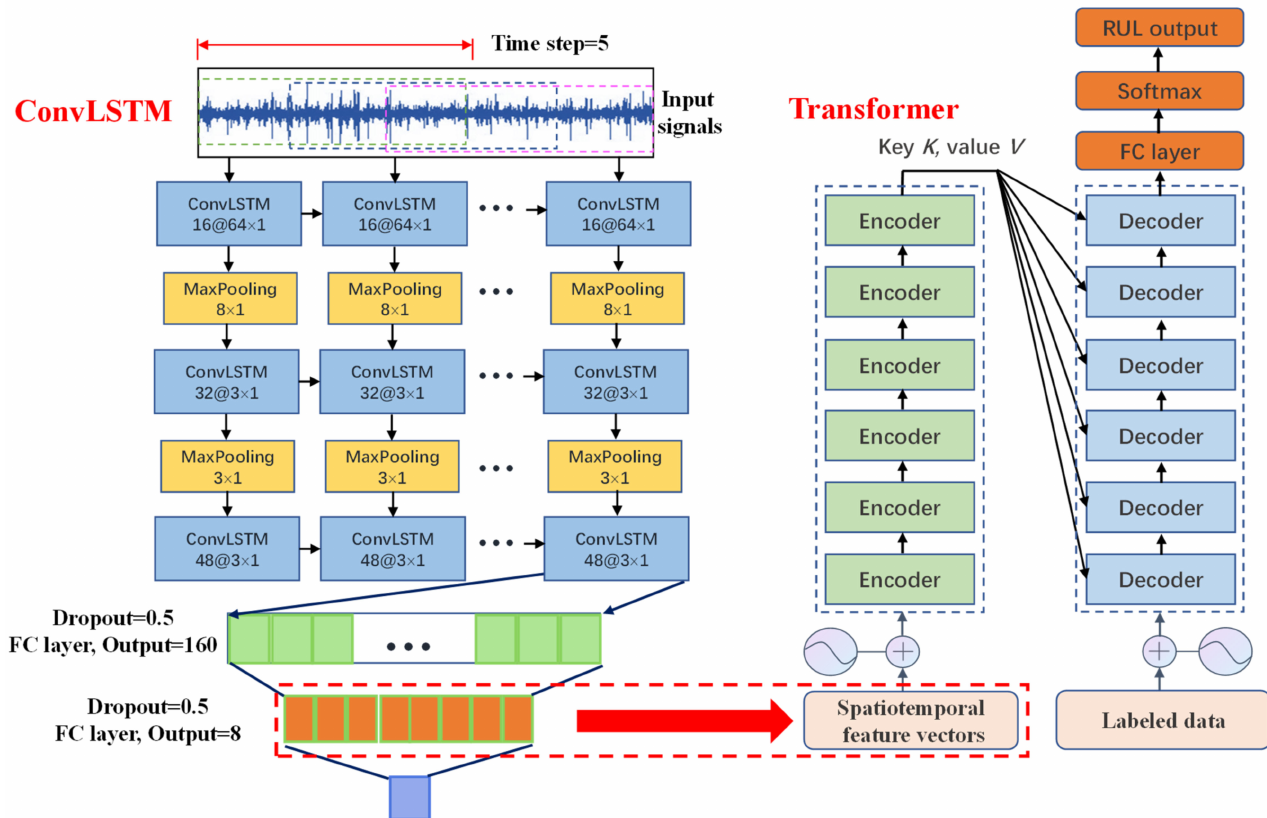
Figure 9. Architecture of the proposed ConvLSTM-Transformer model.